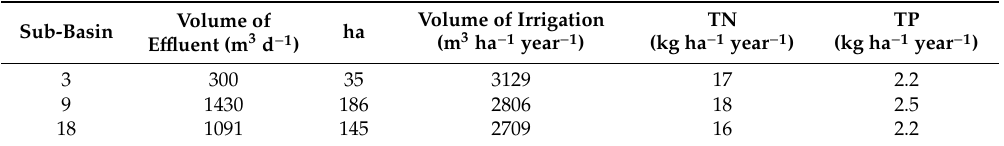
Table 1. Volumes of e ffl uent from WWTPs and irrigated areas, and volumes of irrigation water and nutrient loads (TN, TP) made to the soil from